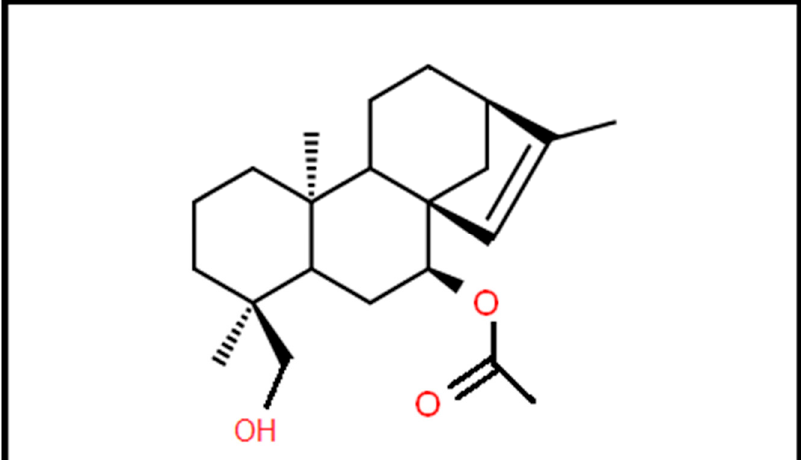
Figure 1. Molecular structure of siderol.